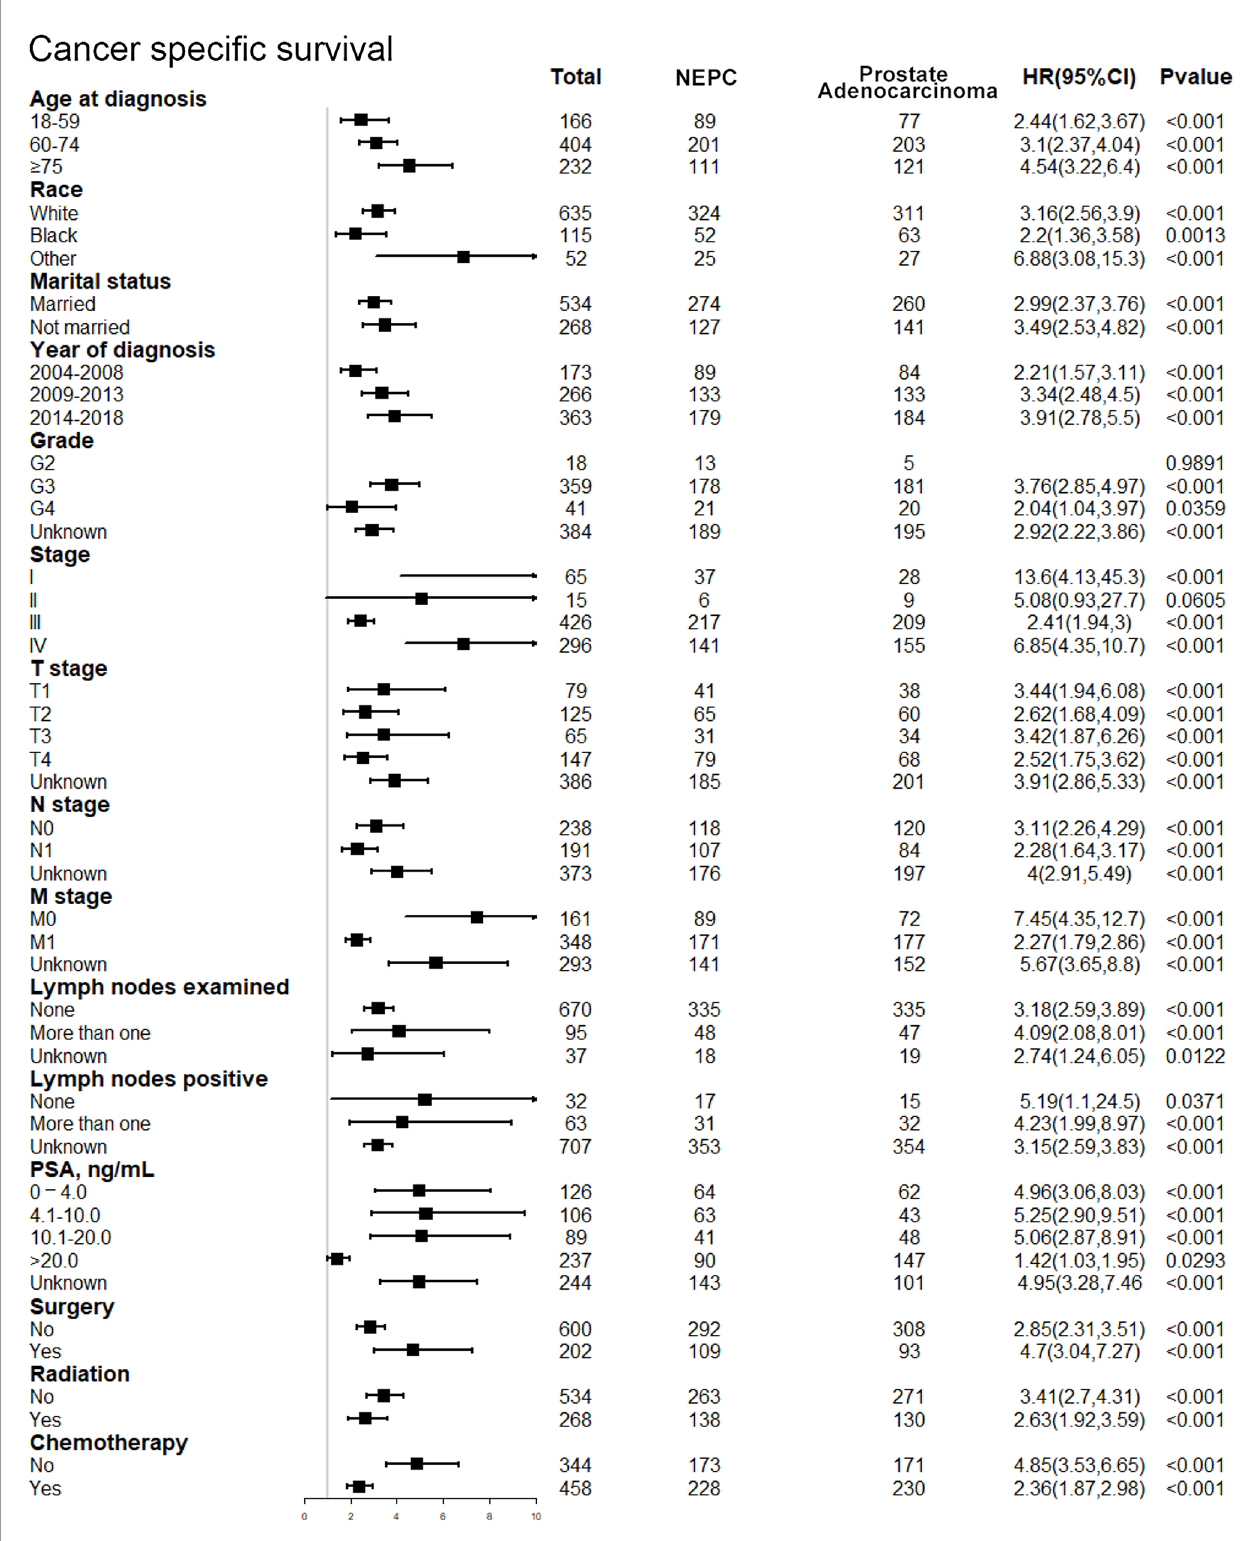
Frontiers in Endocrinology |